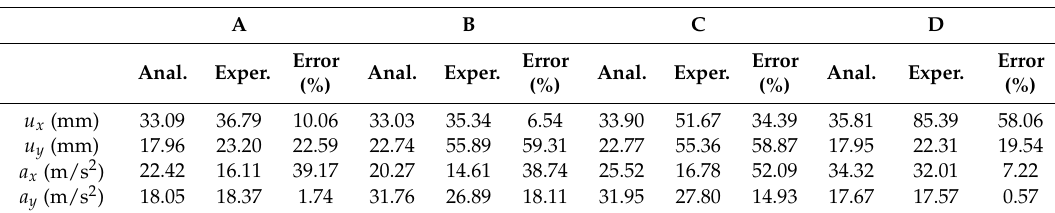
Table 11. Absolute maximum seismic responses at sampling points A to D in both x and y directions for the analysis case of Run 19.